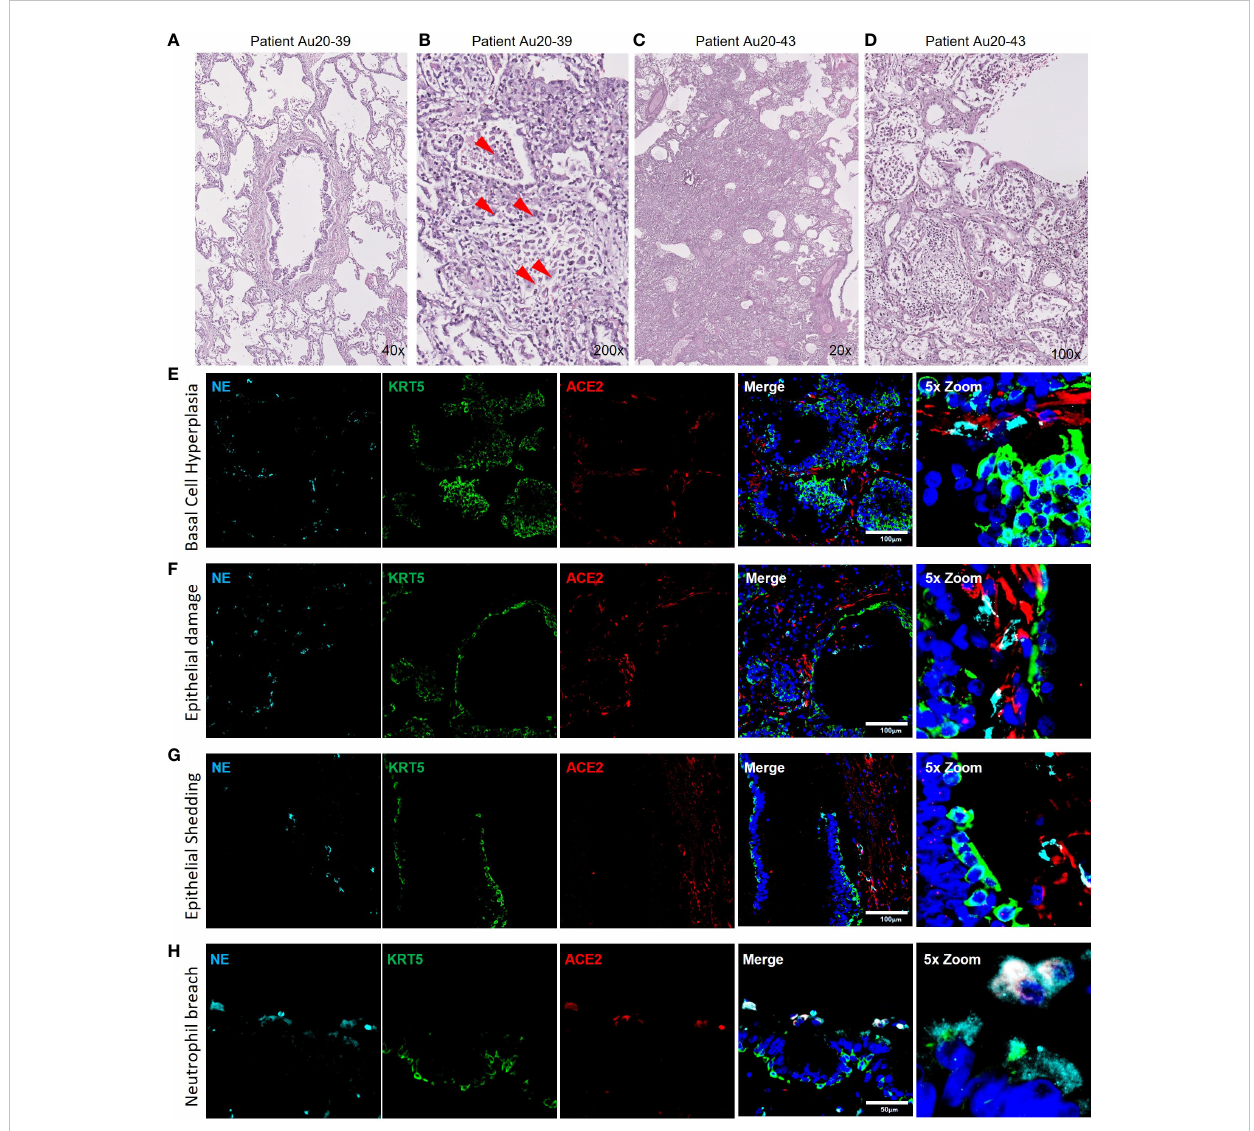
FIGURE 4 Neutrophil associated tissue pathology in post-mortem COVID19 human lung airways. a-d) Representative images of hematoxylin and eosin (H&E) staining of postmortem COVID-19 patient tissues showing patchy organizing pneumonia centered around a major artery and an airway (A) ; focally expanded interstitium by a mixed cellular in fi ltrate including scattered giant cells (red arrowheads) (B) ; diffuse alveolar damage from intense fi broin fl ammatory process and barotrauma induced rounded airspaces (C) and organizing diffuse alveolar damage with fi brin disposition replaced by organizing pneumonia, in fl ammatory cells and oedema (D) . (E-H) Representative IF images of postmortem COVID-19 tissue probed for NE (cyan), KRT5 (green) and ACE2 (red). Images highlight; small airway occlusion resulting from basal cell hyperplasia with surrounding neutrophils present (E) ; epithelial damage with breaching neutrophils into the luminal space (F) ; epithelial shedding, inclusive of basal cell layer with neutrophil inclusion of mucosal surface (G) ; neutrophil breach into airway luminal space with high neutrophil elastase activity (H) . All IF images have nuclei counterstained with DAPI (blue) and scale bars represent 100 m m. All images are representative of 3 independent regions per donor at least 2 independent